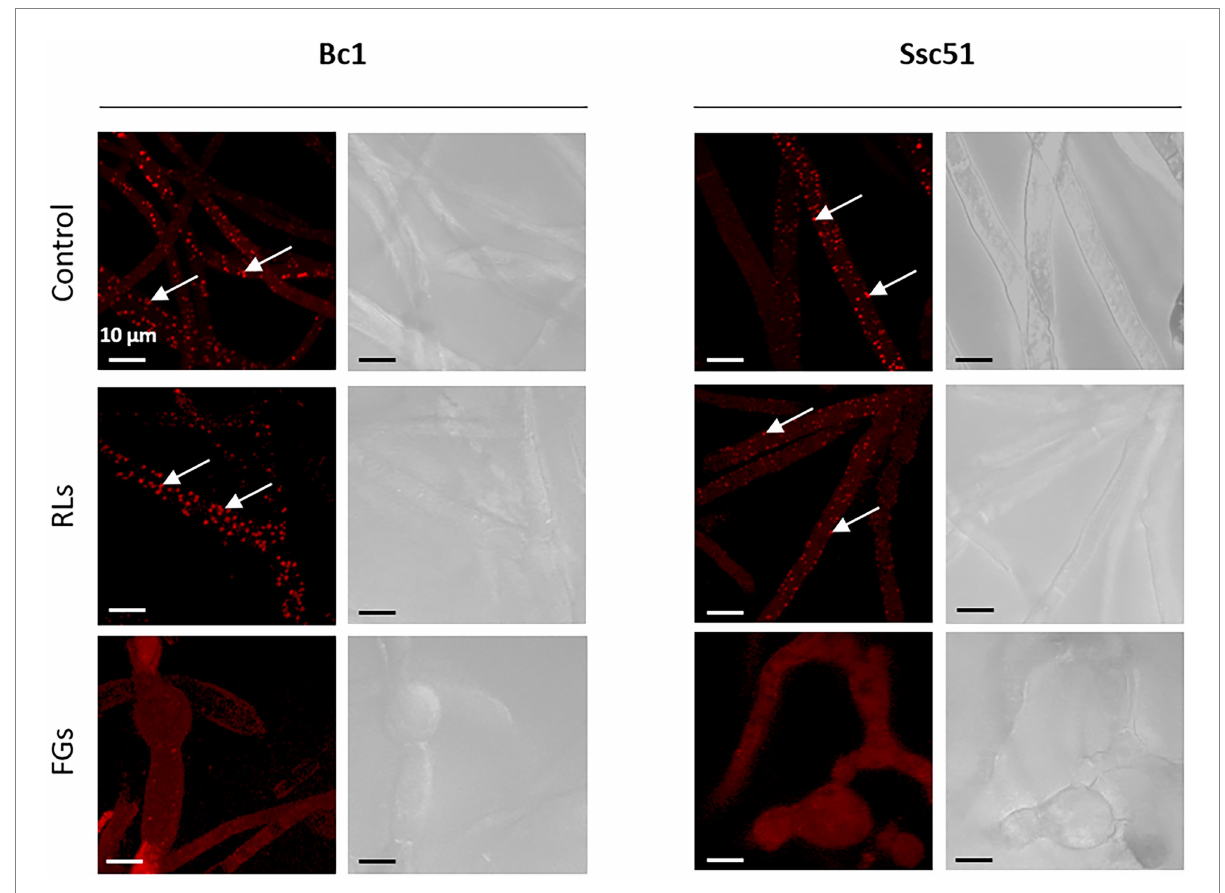
FIGURE 4 Nile red lipid droplets coloration of Bc1 and Ssc51 mycelium after 25 μ g mL − 1 RLs and 50 μ g mL − 1 FGs treatments. White arrows indicate lipid droplets. Scale bar: 10 μ